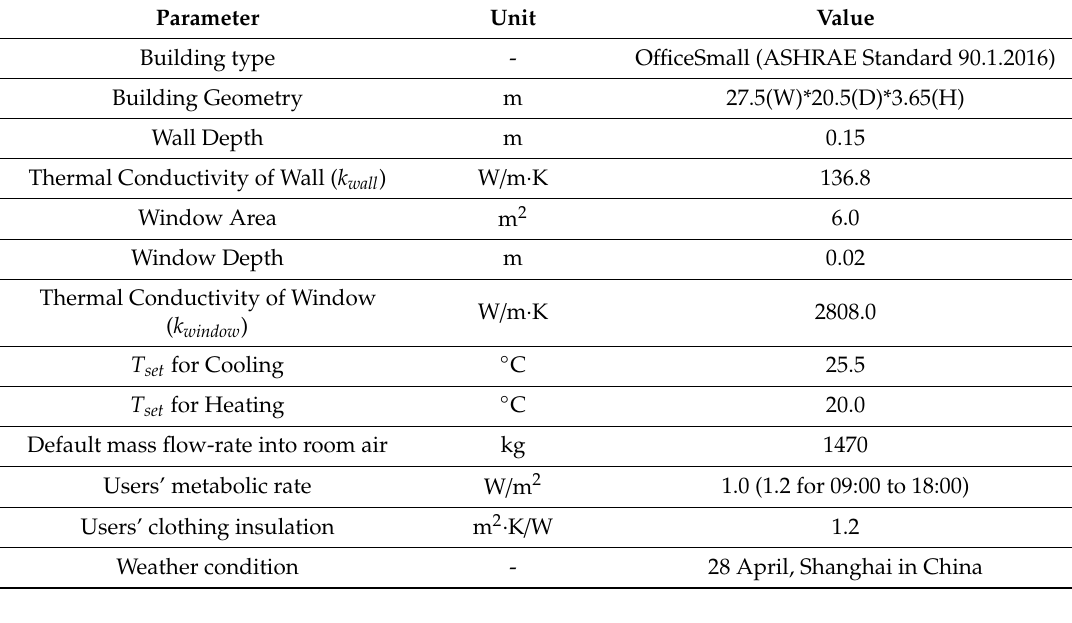
Table 1. Design Table 1. Design parameters.